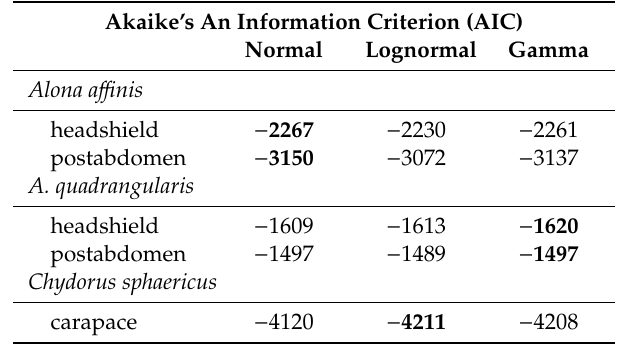
Figure A5. Size–frequency distribution of cladocera remains. Table A2. Akaike’s information criteria for L-S and T-S models. Smallest values are marked in